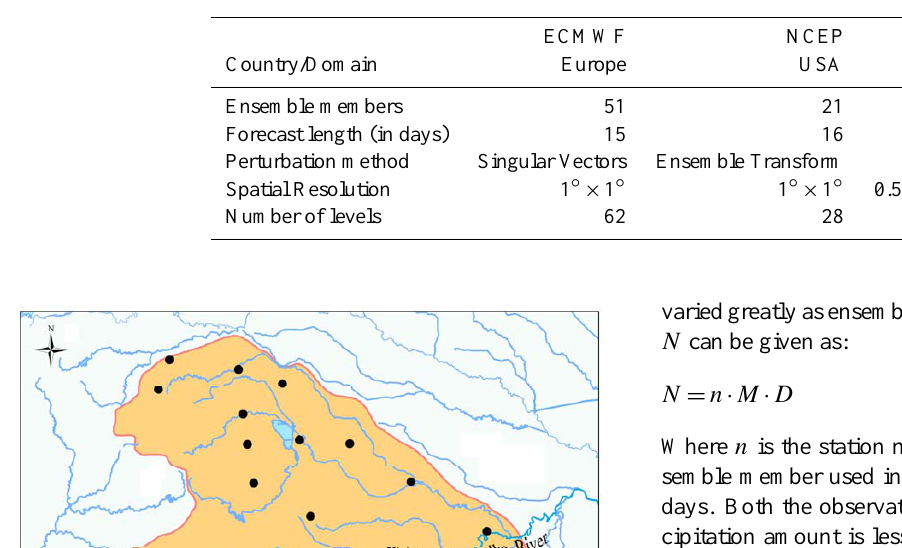
Table 1. Comparison of the ensemble systems used in this study.